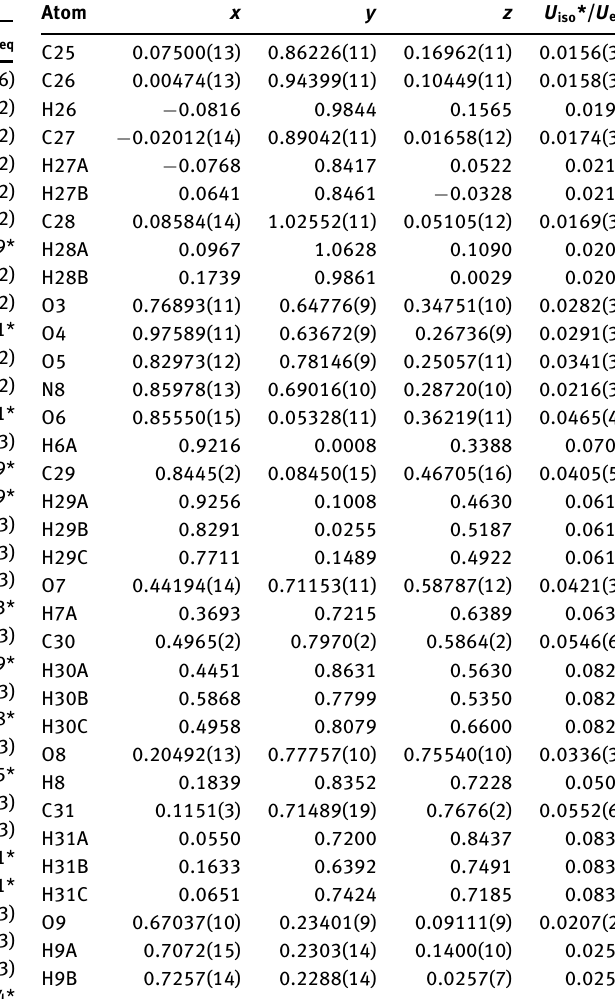
Table 2: Fractional atomic coordinates and isotropic or equivalent isotropic displacement parameters (Å 2